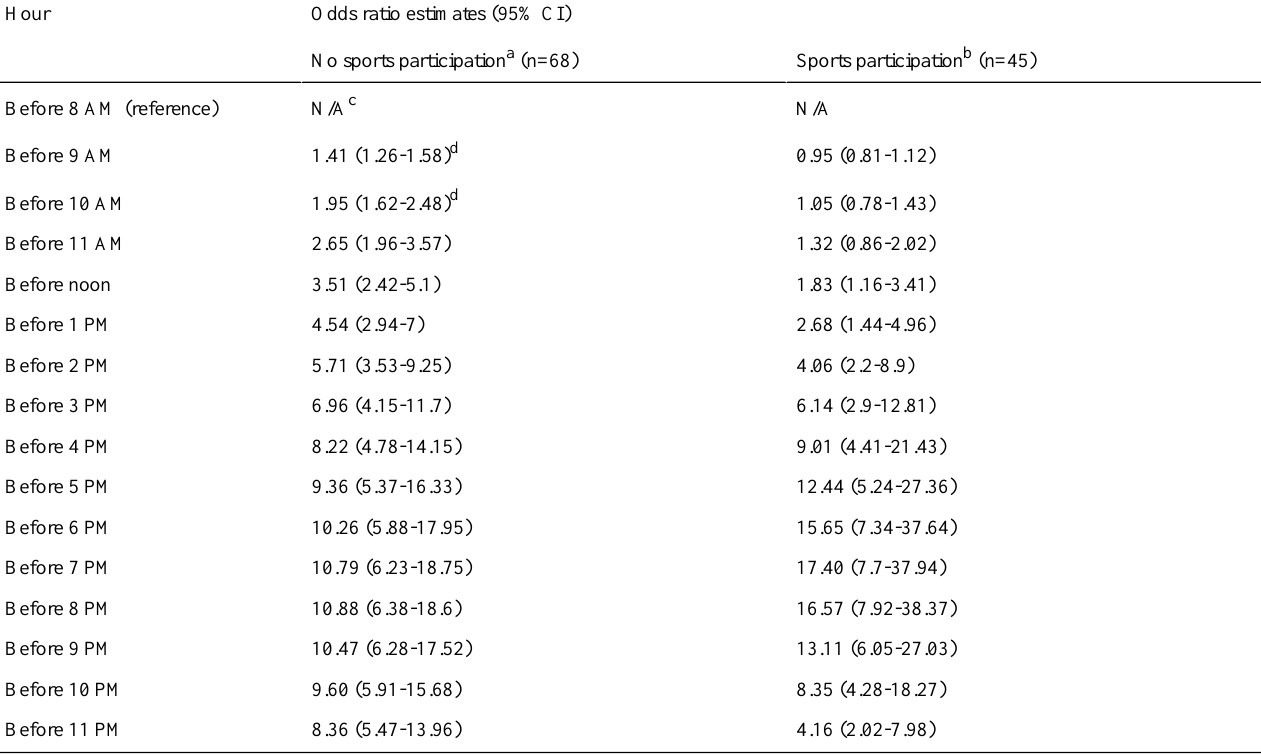
Table 4. Moderating effect of involvement in organized sports (sports participation) on odds ratio estimates of time of average moderate-to-vigorous physical activity